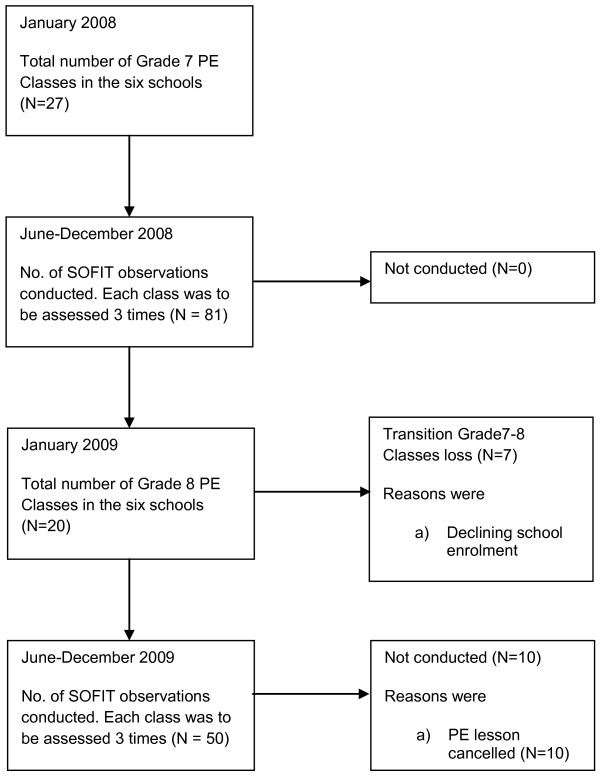
Flowchart for the study.